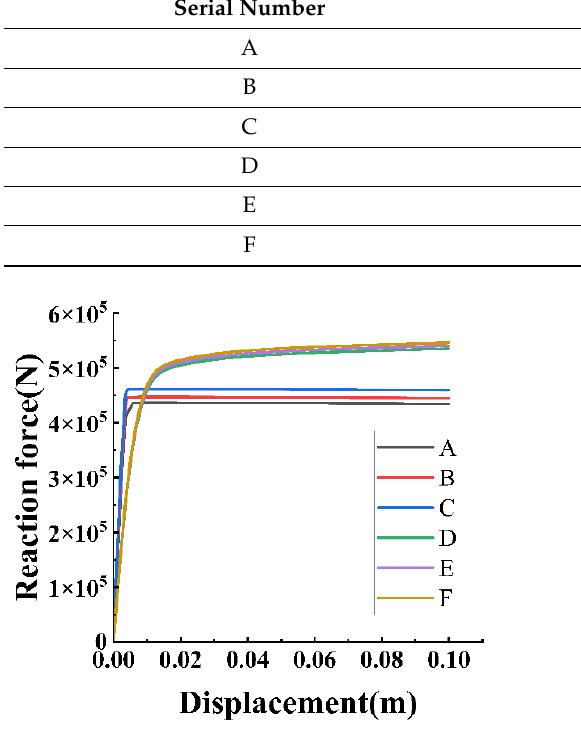
Figure 10. Bearing capacity curves of different elements.